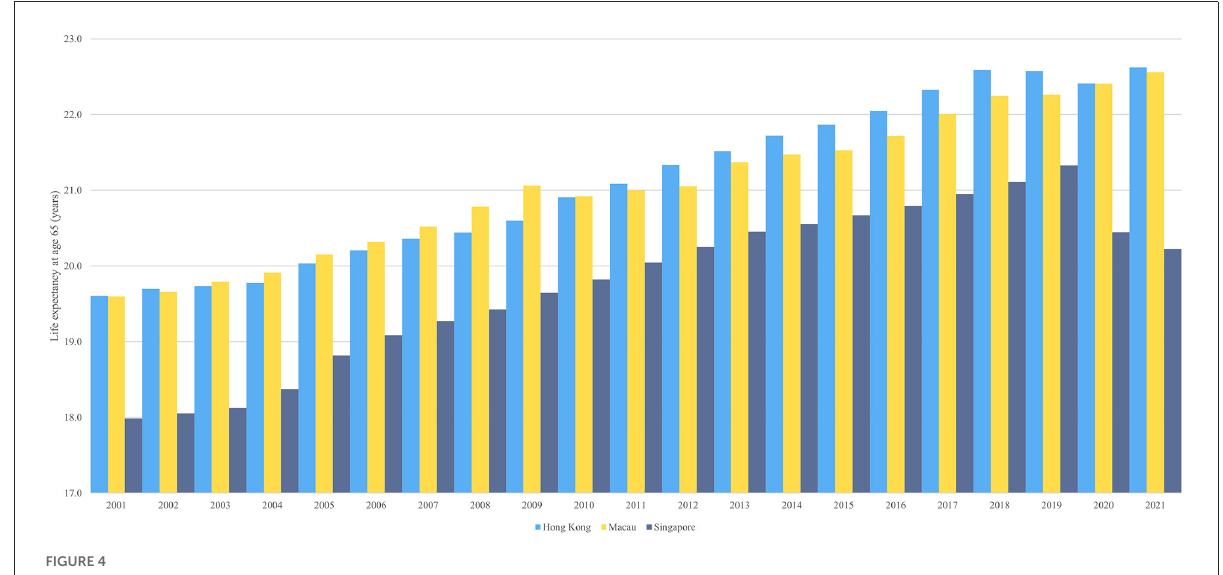
FIGURE4 Life expectancy at age 65 in Hong Kong, Macau, and